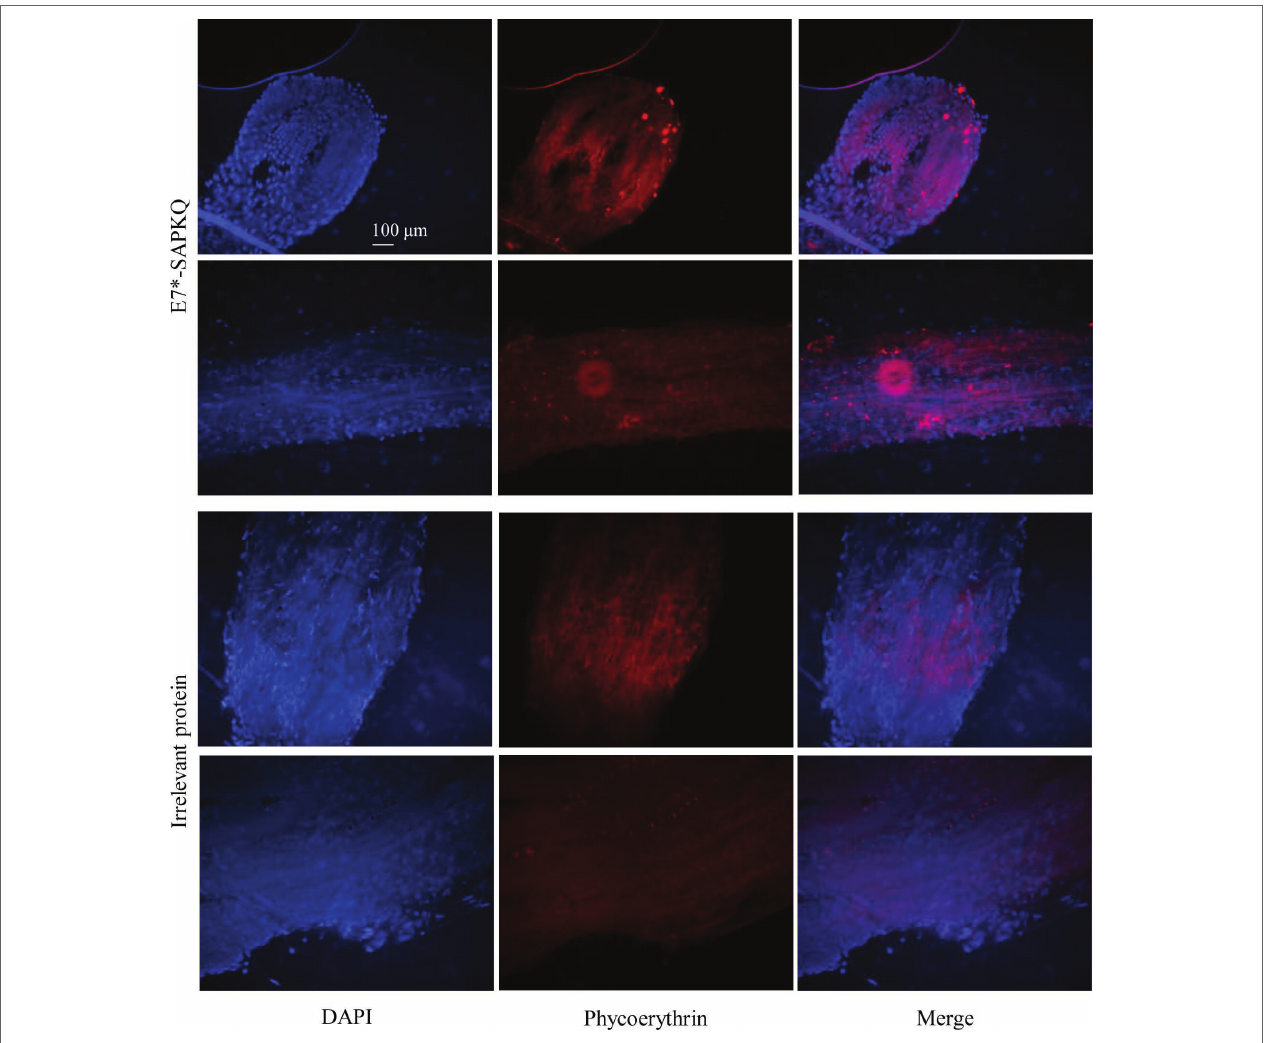
FIGURE 5 | Immunofluorescence microscopic analysis showing expression of His 6 -E7*-SAPKQ in the root cap/apical meristem and along the region of elongation/ maturation of a transformed hairy root clone from Micro-Tom. Original magnification 20×. Scale bar = 100